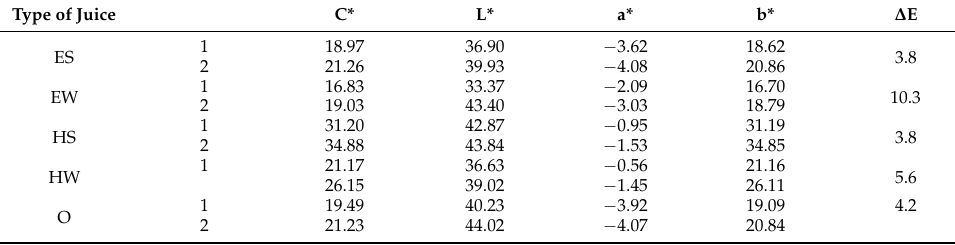
Table 4. L*a*b* colour rating and colour difference ∆ E before (1) and after pasteurisation (2). Type of Juice